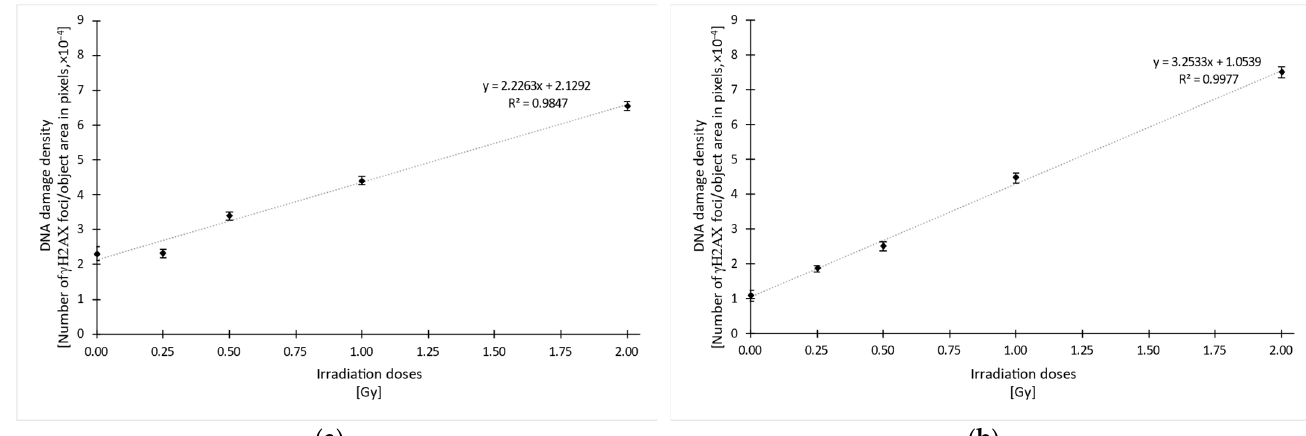
Figure 7. Quantified DNA damage density in terms of the number of γ H2AX foci per object area, in pixels, for each irradiation dose condition, for control cells ( a ) and AuNP-treated cells ( b ). Error bars represent the mean standard error. The linear regression equation is shown in the graph, along with the R 2 value. R 2 is statistically significant, with p < 0.001.